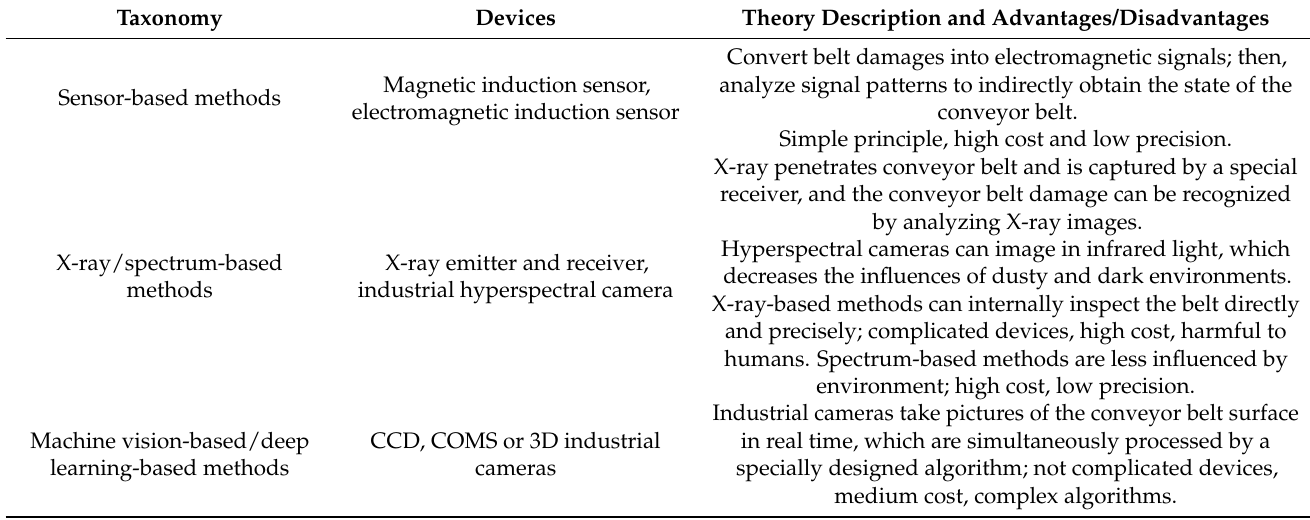
Table 1. Classification of conveyor belt defect detection